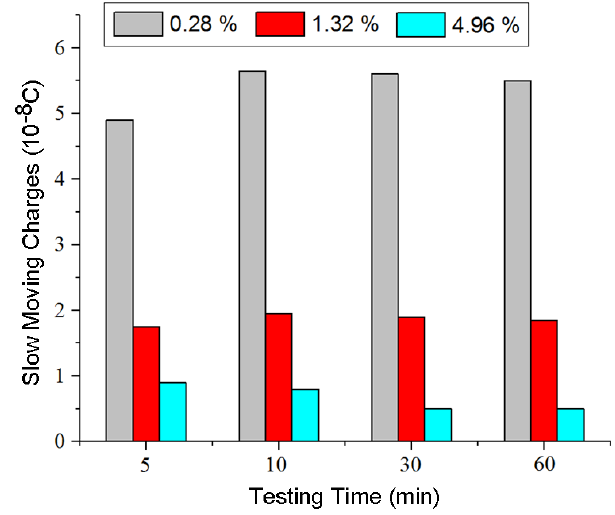
Figure 5. Total absolute amount of slow moving charges in the oil ‐ paper sample with different moisture content under the volt ‐ off condition (6 kV) at 15 °C.